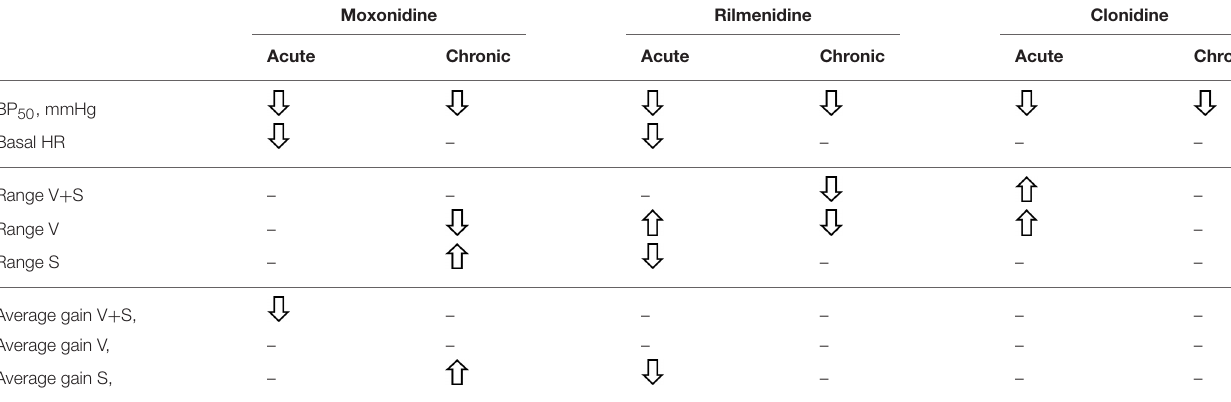
TABLE 7 | Comparison of chronic and acute effect of moxonidine, rilmenidine and clonidine on baroreflex curve